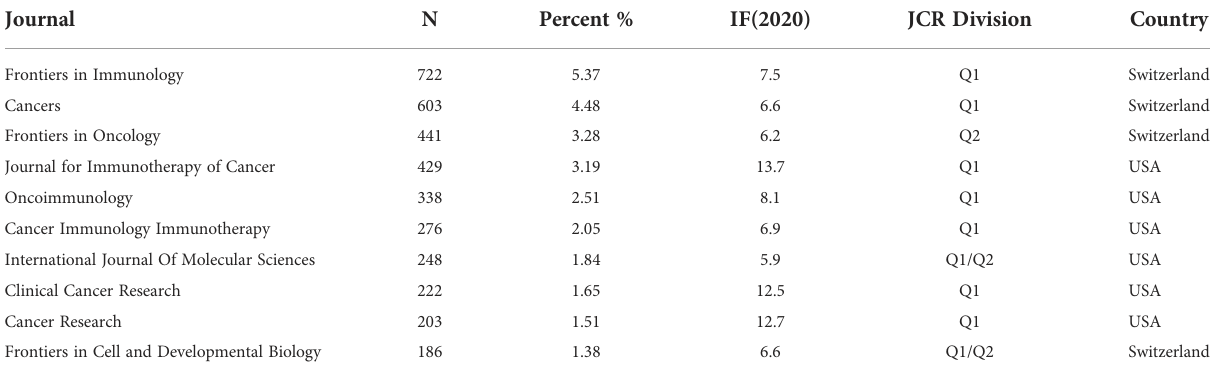
TABLE 1 The top 10 journals of immunotherapy-TME-related